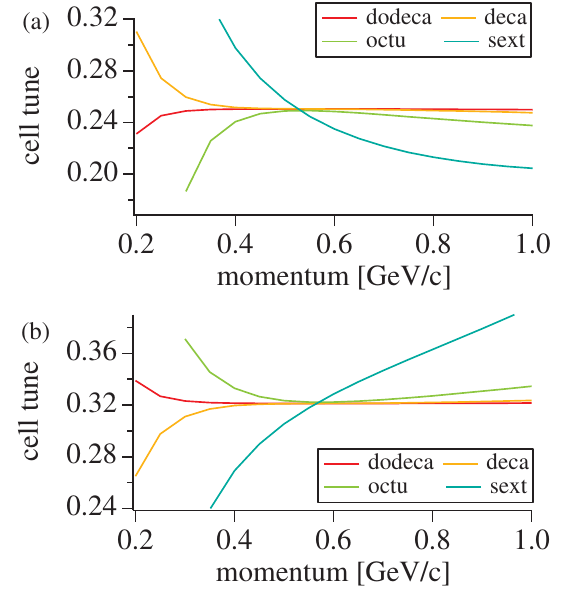
FIG. 1. (Color) Cell tune with momentum: (a) horizontal, (b) vertical. The terms dodeca, deca, octa, and sext indicate that the maximum order of the expansion is dodecapole, decap- ole, octapole, and sextupole,